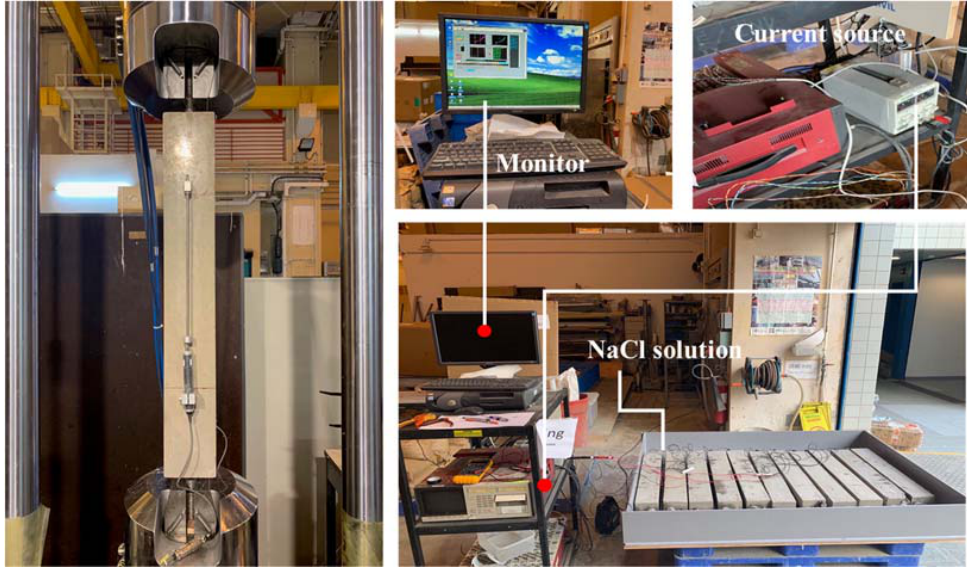
Figure 4. Pre-loading and accelerated corrosion test setup for cement paste and ECC